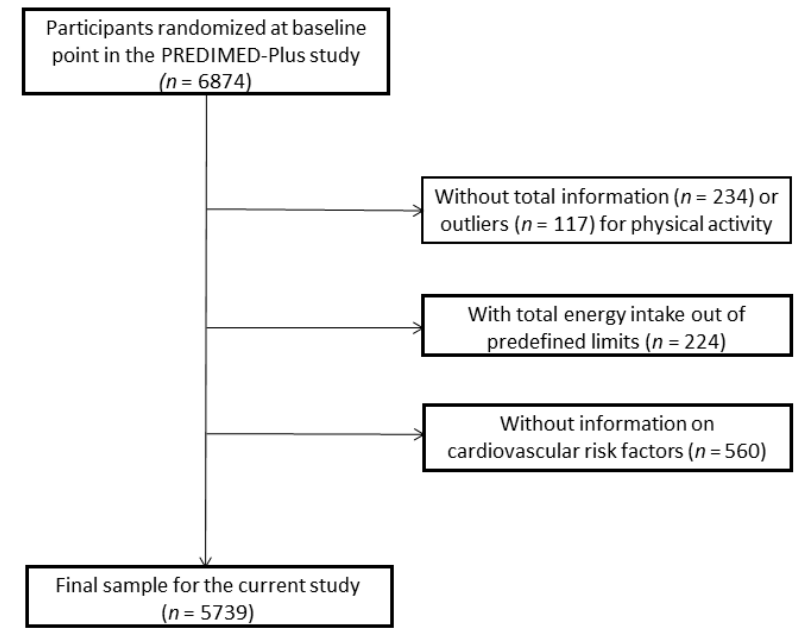
Figure 1. Flow-chart of the study participants.